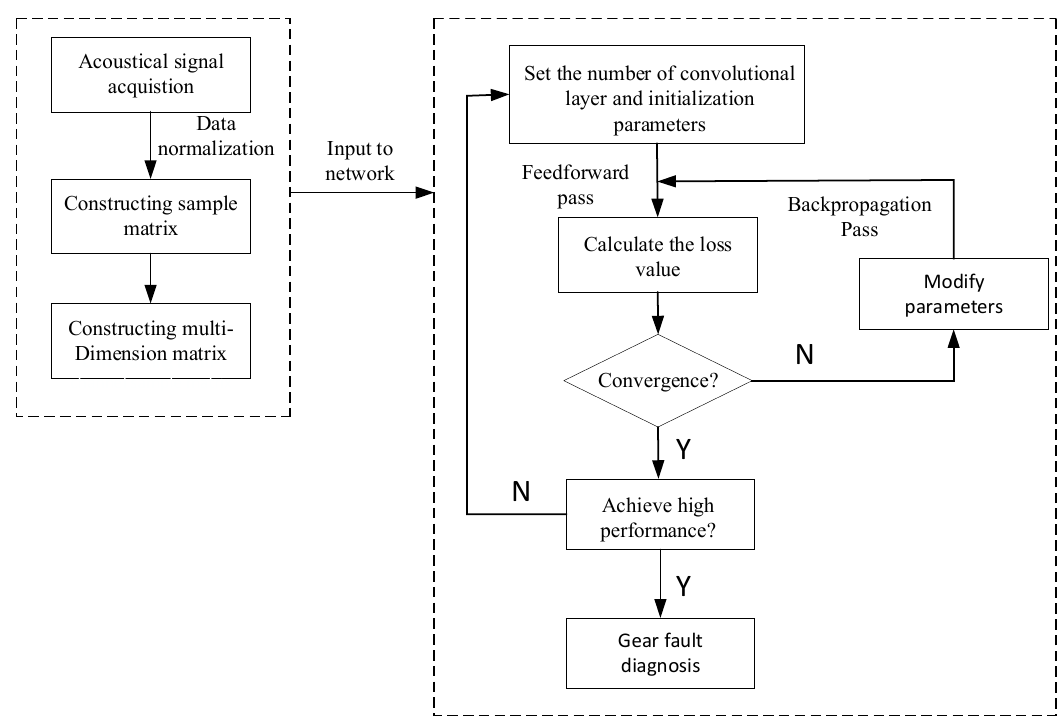
Figure 1 . Block diagram of the proposed method. Figure 1. Block diagram of the proposed